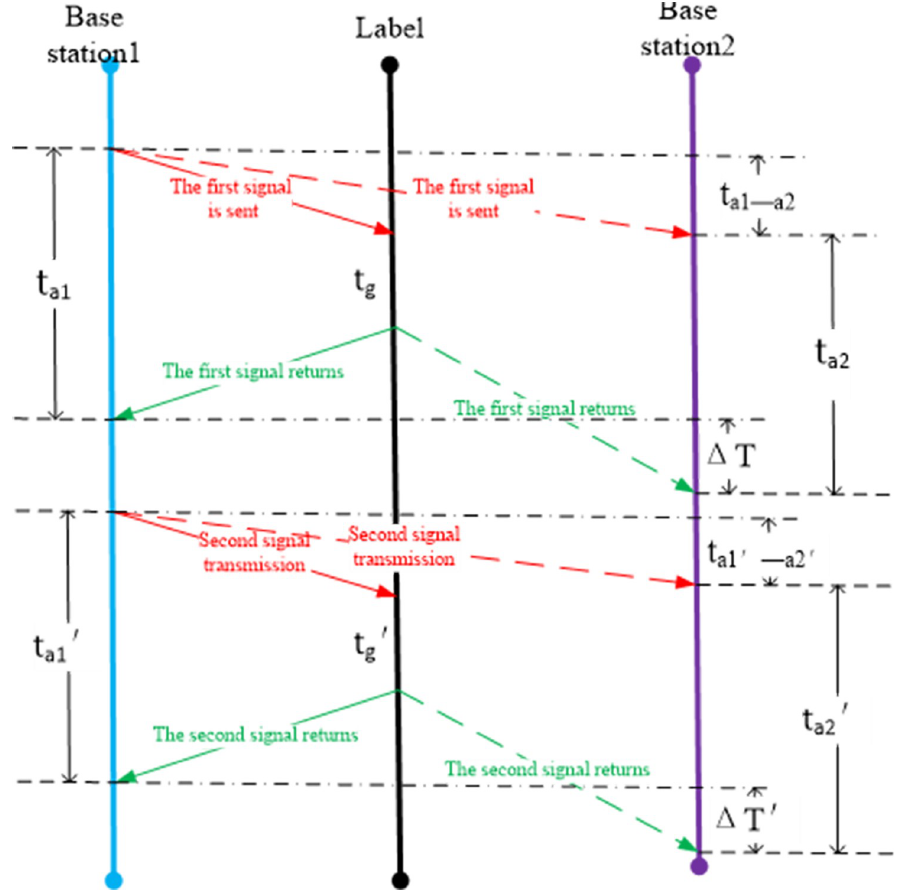
Fig 3. Schematic diagram of the wireless pulse flight